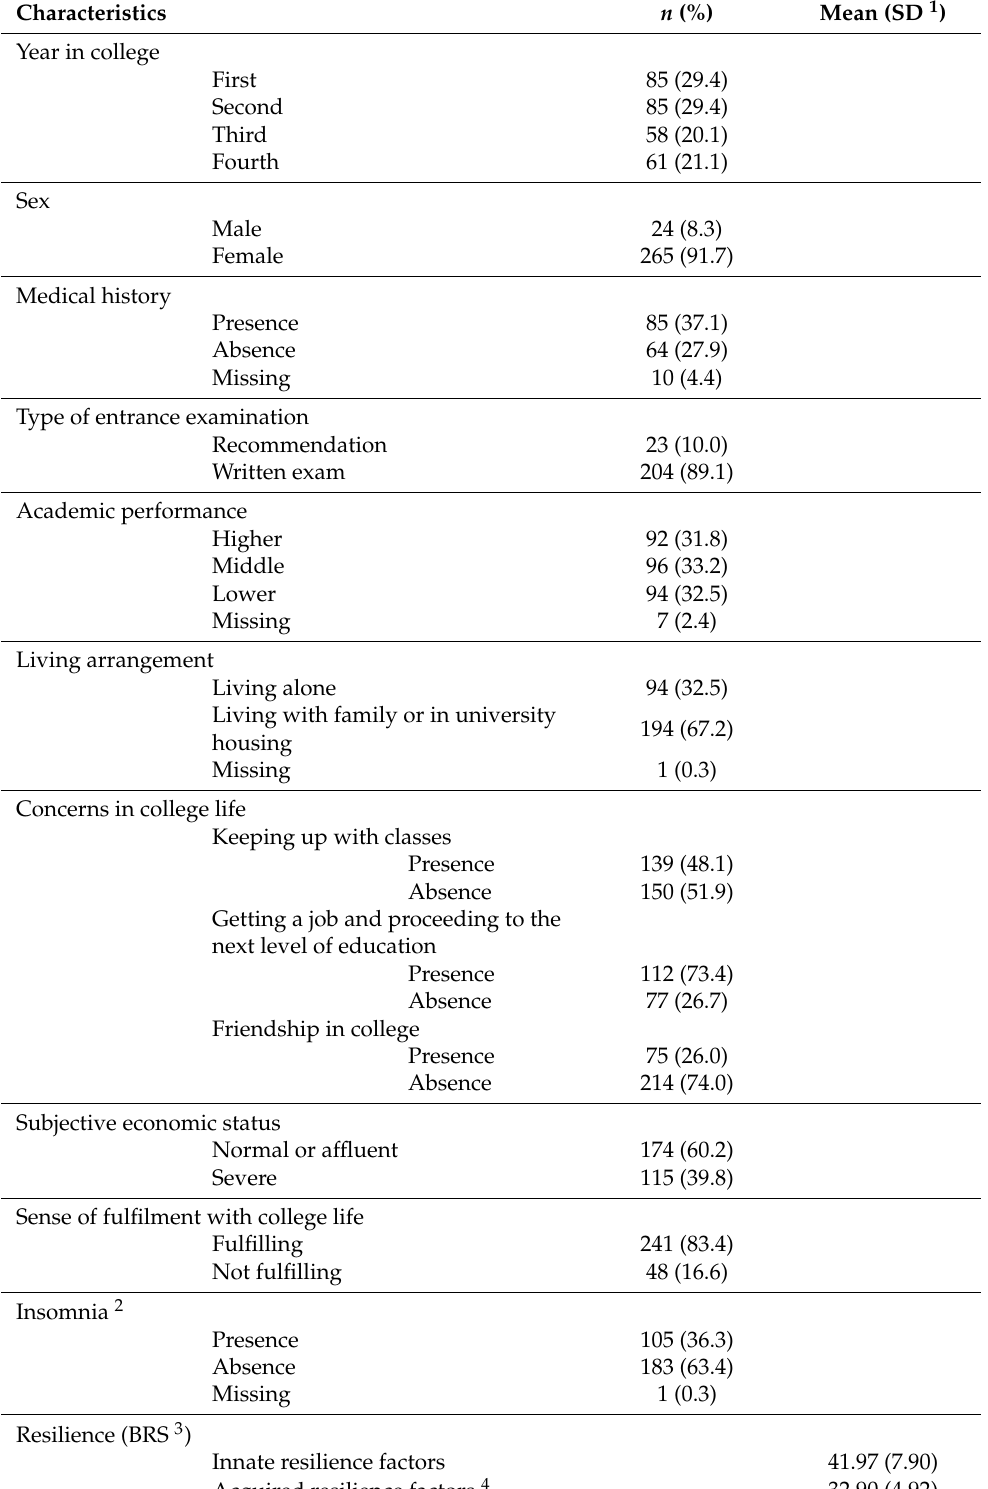
Table 1. Characteristics of the study participants ( n =